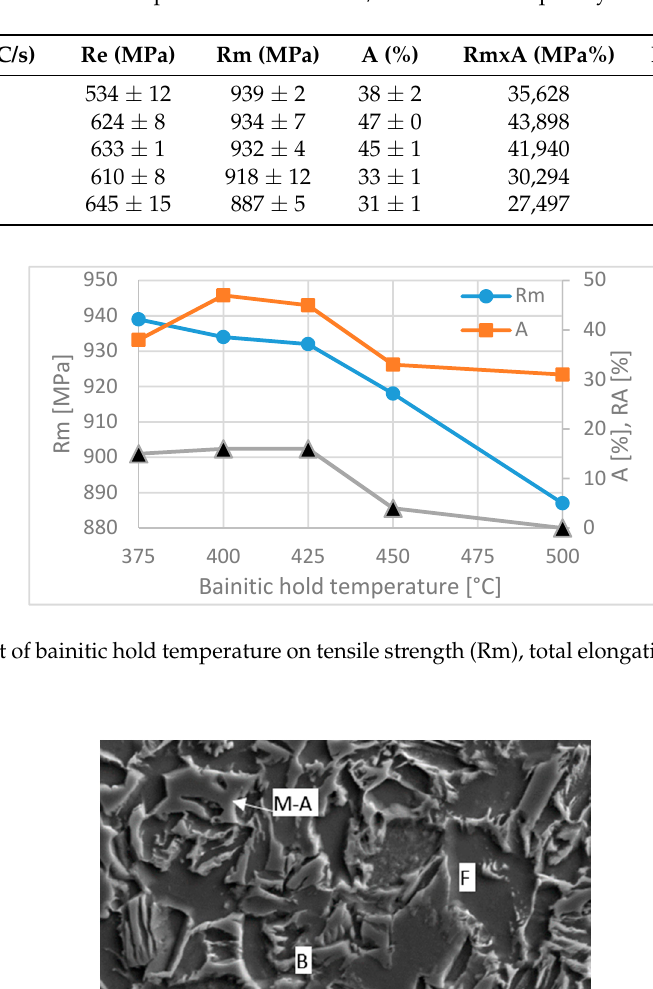
Figure 12. Heat treatment parameters: Soaking 850 °C/100 s, cooling rate 30 °C/s, bainitic hold 375 °C/600 s. Ferritic-bainitic microstructure with M-A constituent and very fine pearlite.